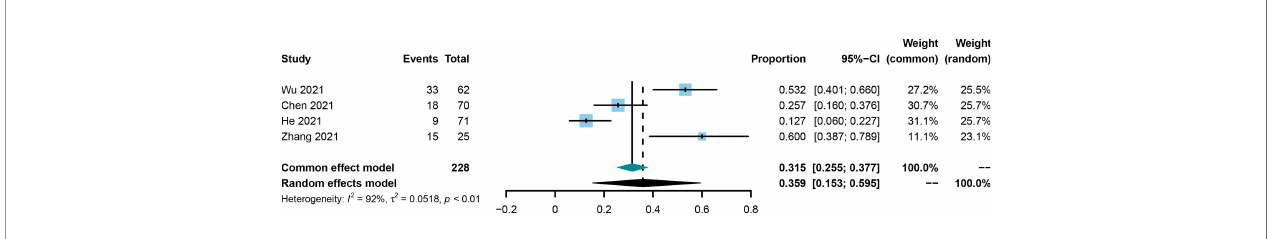
FIGURE 5 | Forest plot of the pooled surgical conversion rate.